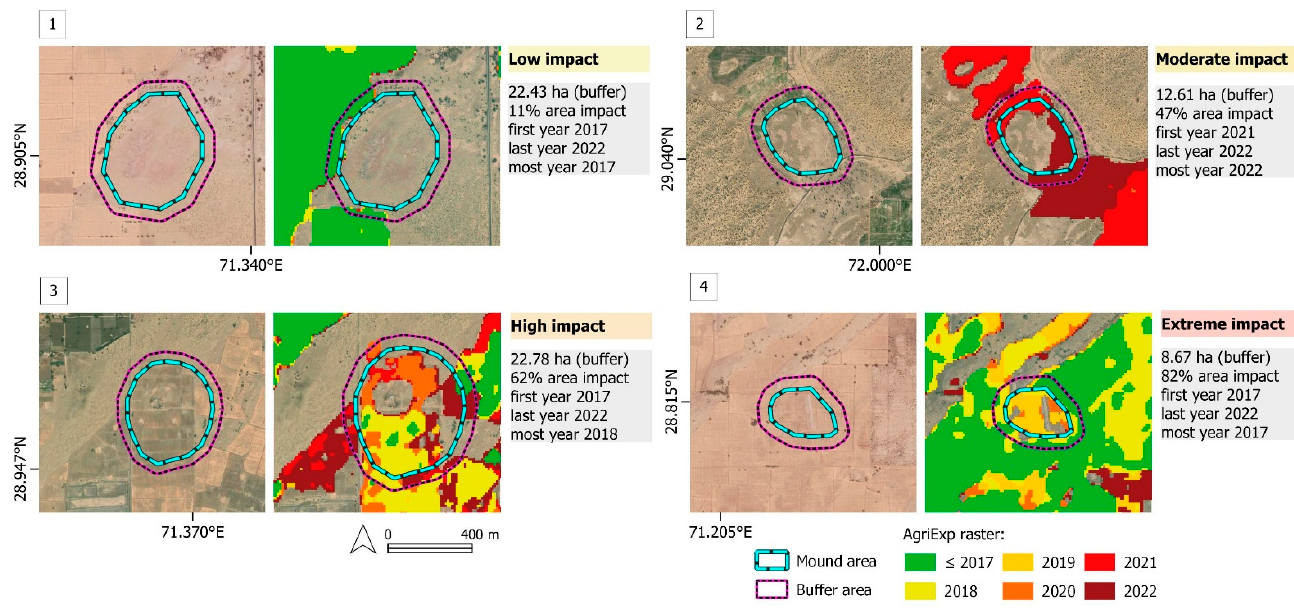
Figure 3. Example of the categorical classification of endangered buffered areas with the newly listed levels: ( 1 ) low impact, ( 2 ) moderate impact, ( 3 ) high impact and ( 4 ) extreme impact. For each site, the algorithm also outputs a list of spatial variables: the buffer area (ha), the percentage of area with encroachment, and the first, last and most abundant yearly occurrences of agricultural encroachment within the site’s buffer. Base map: Google